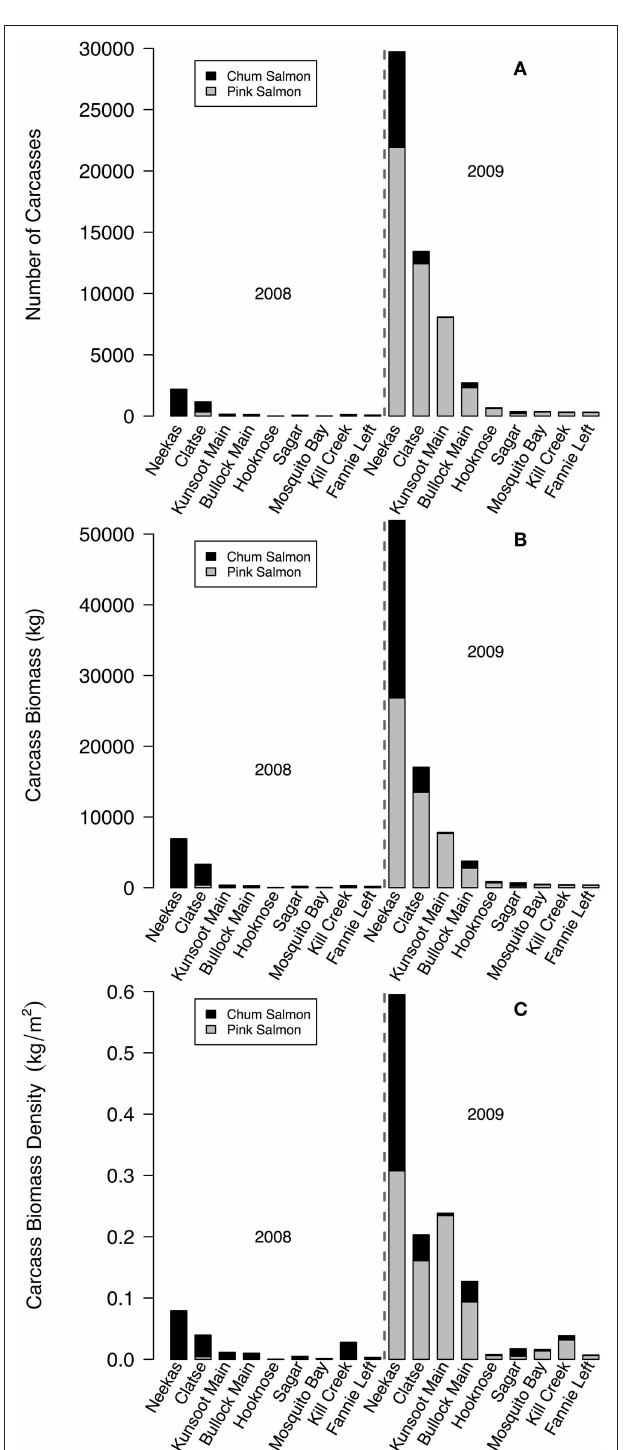
FIGURE 9 | Contributions of salmon carcasses to each estuary for 2008 (a low pink return year) and 2009 (a high pink return year), indicating (A) total number of carcasses; (B) total biomass of carcasses (kg); and (C) biomass density of carcasses (kg/m 2 ). Salmon biomass was calculated by measuring the weight of 5 dead adult salmon of each sex for each species in a subset of study streams covering our study area in 2009. Biomass densities are calculated for the total area of exposed estuary at a 0m